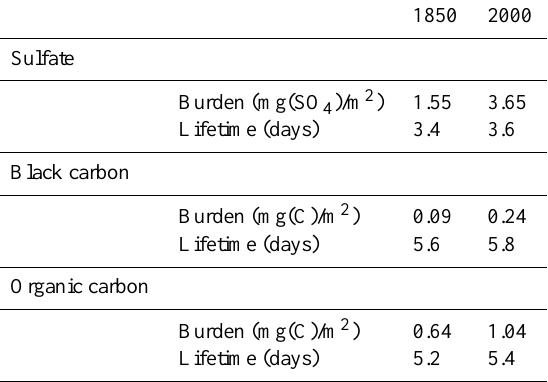
Global burden and lifetime for anthropogenically- perturbed aerosols in 1850 and 2000 for the CAM-chem